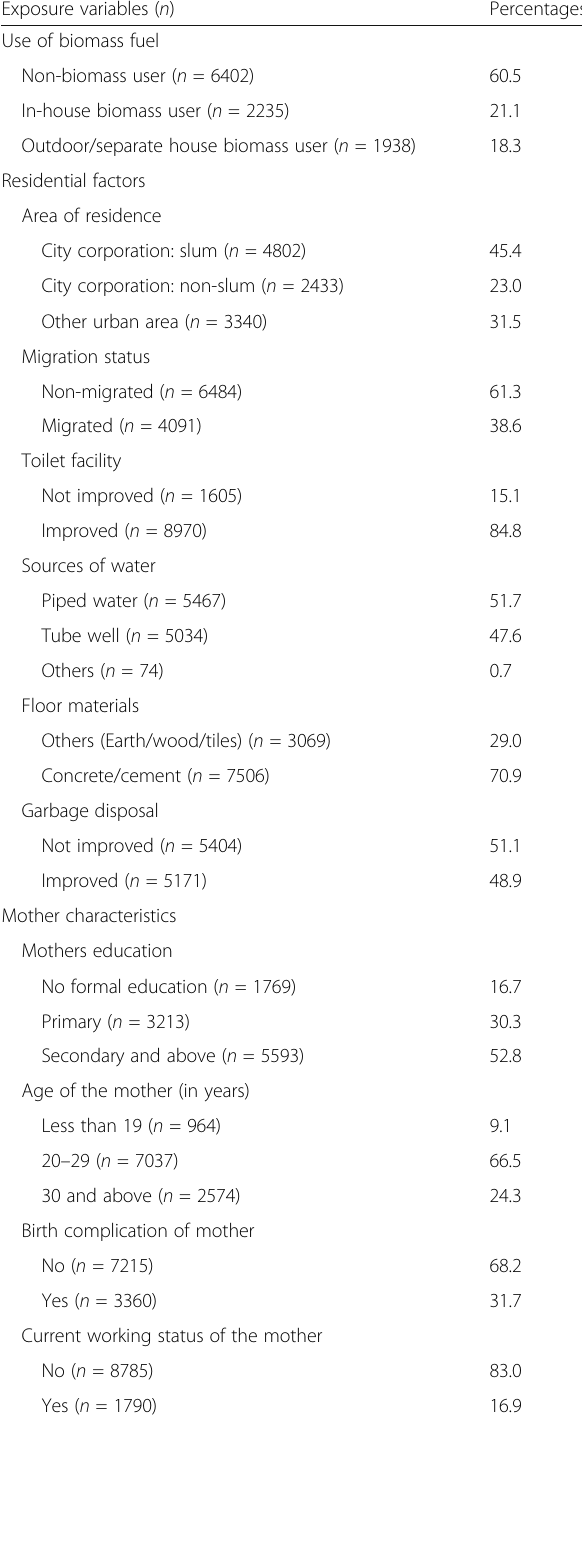
Table 1 Descriptive statistics of participant ’ s residential factors, mother ’ s characteristics, and child characteristics